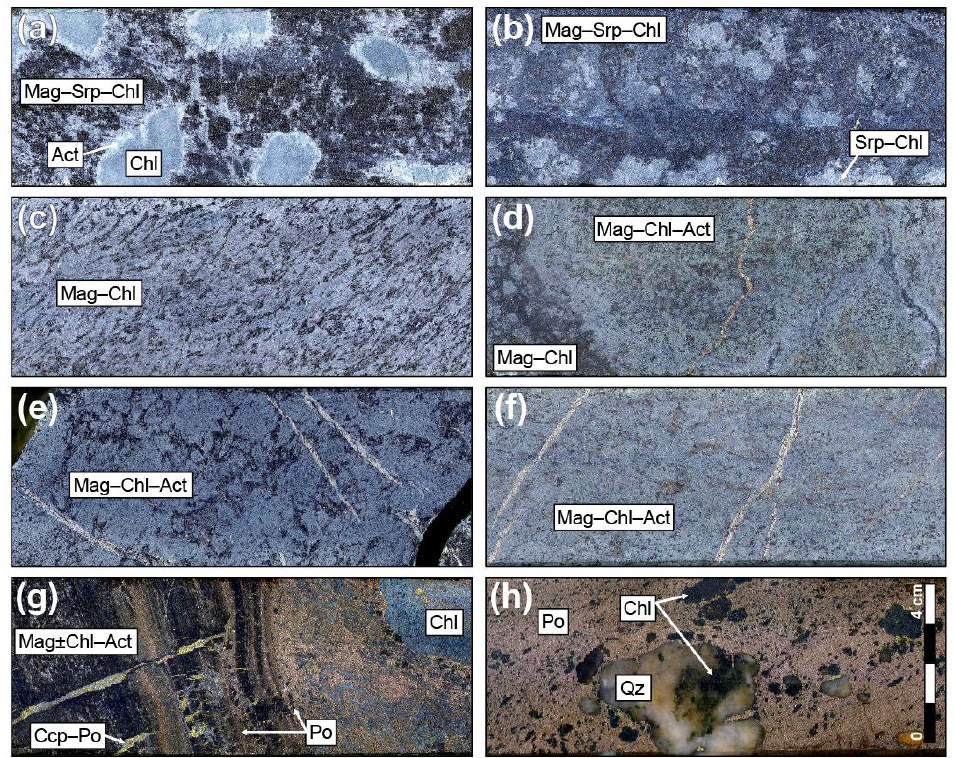
Figure 4. Photographs of half-core samples from drill hole MS-13-17. The samples are: ( a ) MS17-28; ( b ) MS17-37; ( c ) MS17-31; ( d ) MS17-42; ( e ) MS17-01; ( f ) MS17-02; ( g ) MS17-04; and ( h ) MS17-07. The scale is shown in ( h ) and mineral abbreviations are as reported in the literature [34].